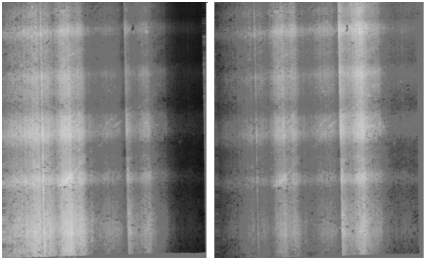
Figure 4: Limoge; residual transverse parallaxes computed for an across-track stereo pair with the matching interval of 0.025 pix. Left: the D 0 ; right: the D 1 , scenarios. The parallax’s magnitudes are found in Tab. 1.